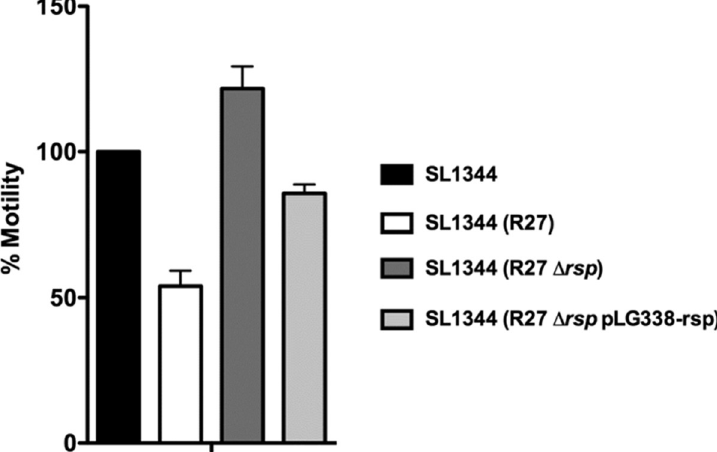
Fig 5. Expression of the RSP protein reduces cell motility. Relative motility of the strains SL1344, SL1344 (R27), SL1344 (R27 Δ rsp ) and SL1344 (R27 Δ rsp pLG338-rsp). Motility of the strain SL1344 (measured as the diameter of the growth zone in the agar plate) was considered as 100%. The results are the means of three independent experiments. Standard deviations are shown.